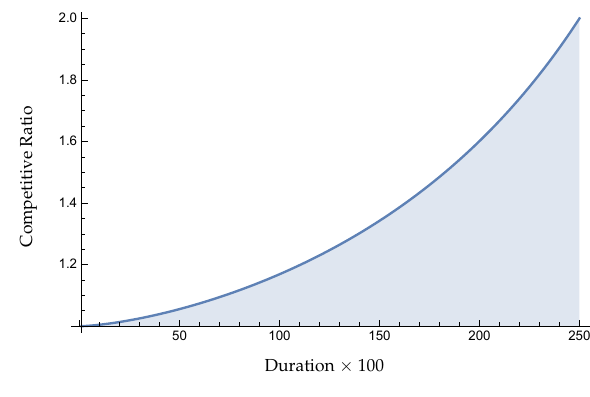
Figure 5. Competitive